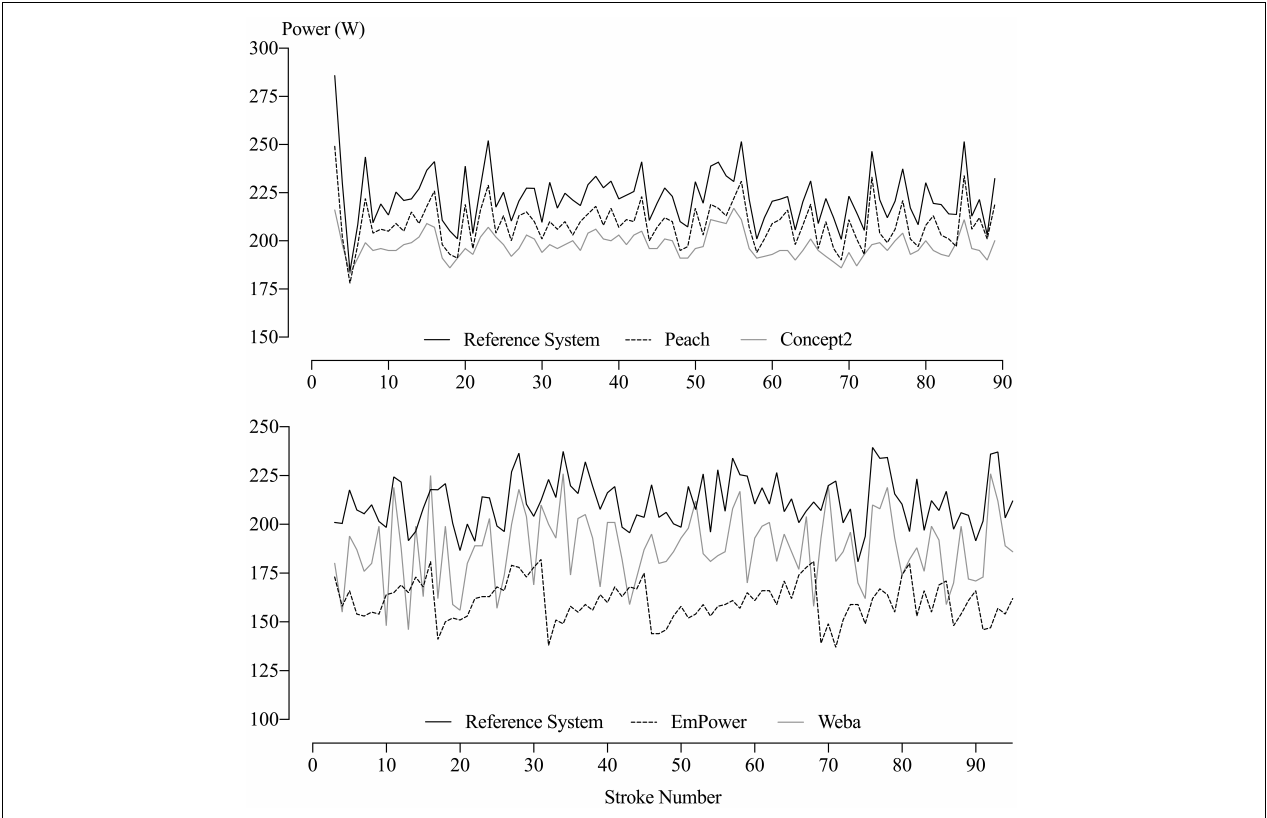
FIGURE 6 | Power per stroke for each device during Stage 5 of two consecutive testing sessions by the same participant. Data for the Weba and Concept2 were recorded in every session but for reasons of clarity are not shown for the Weba (above) or the Concept2 (below).